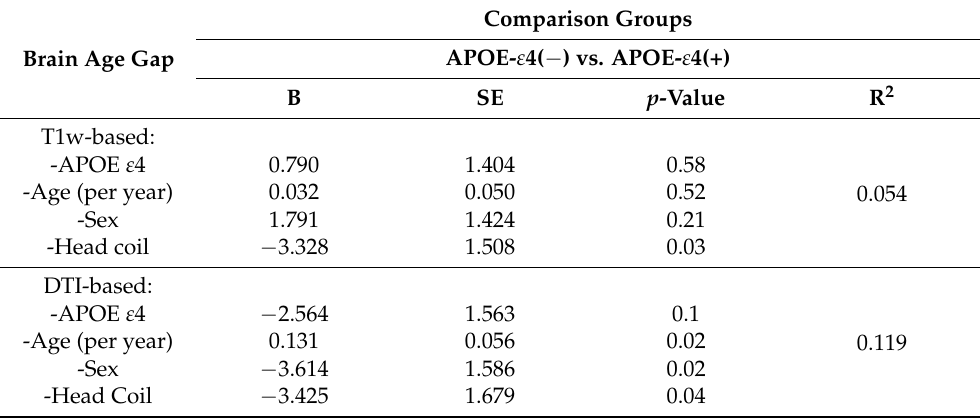
Table 4. Multivariable regression of APOE ε 4status and T1 and DTI brain age